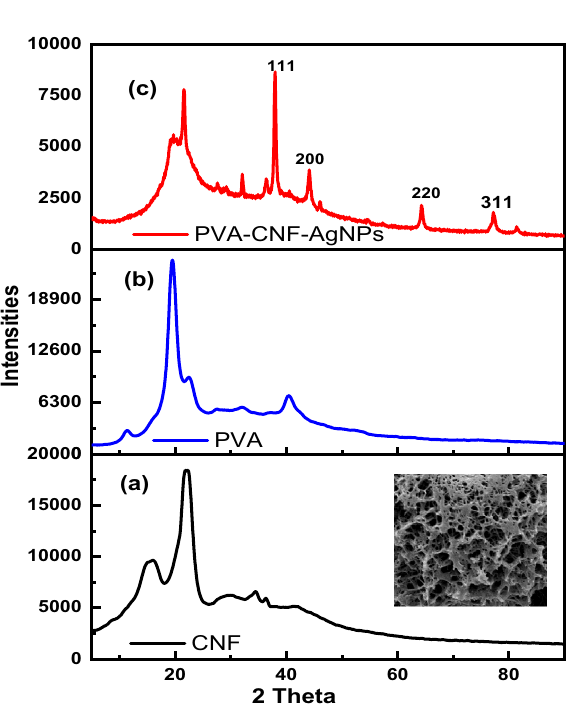
Figure 8. X-ray diffractograms of ( a ) CNF, ( b ) PVA and ( c ) AgNPs@PVA-CNF composite